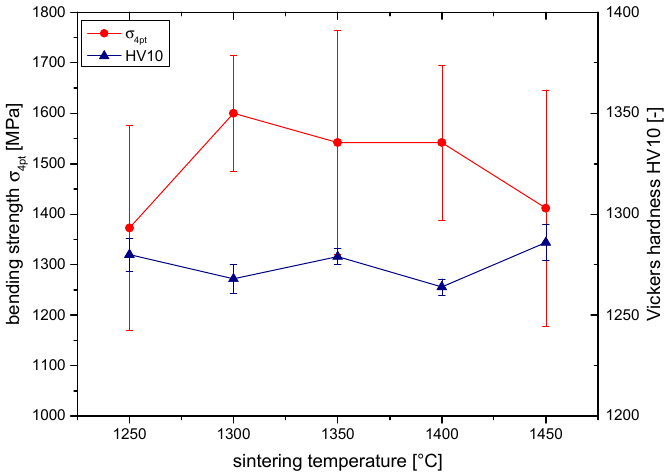
Figure 1. Bending strength σ 4pt and hardness HV10 of 2Y-TZP depending on sintering temperature.